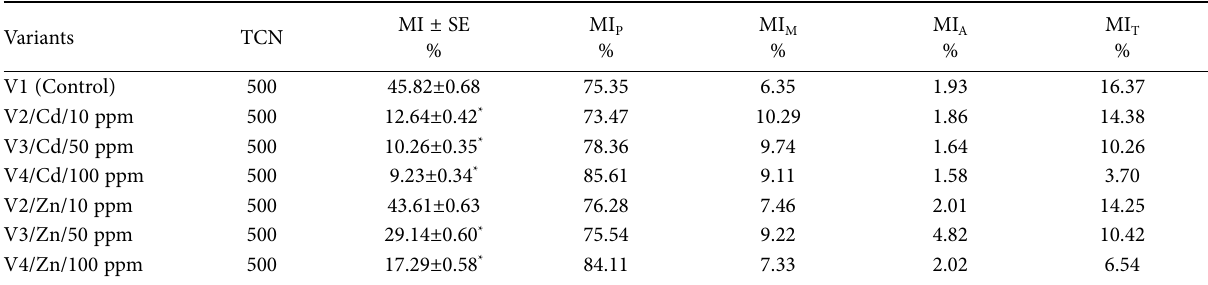
Table 2. Mitotic index (%) and the cell division phases (%) to Ocimum basilicum L. treated with different concentrations of cadmium and zinc